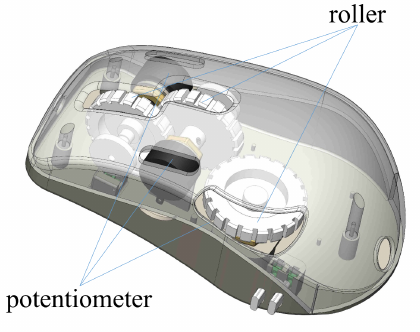
Figure 13. Structural scheme of the mouse-like